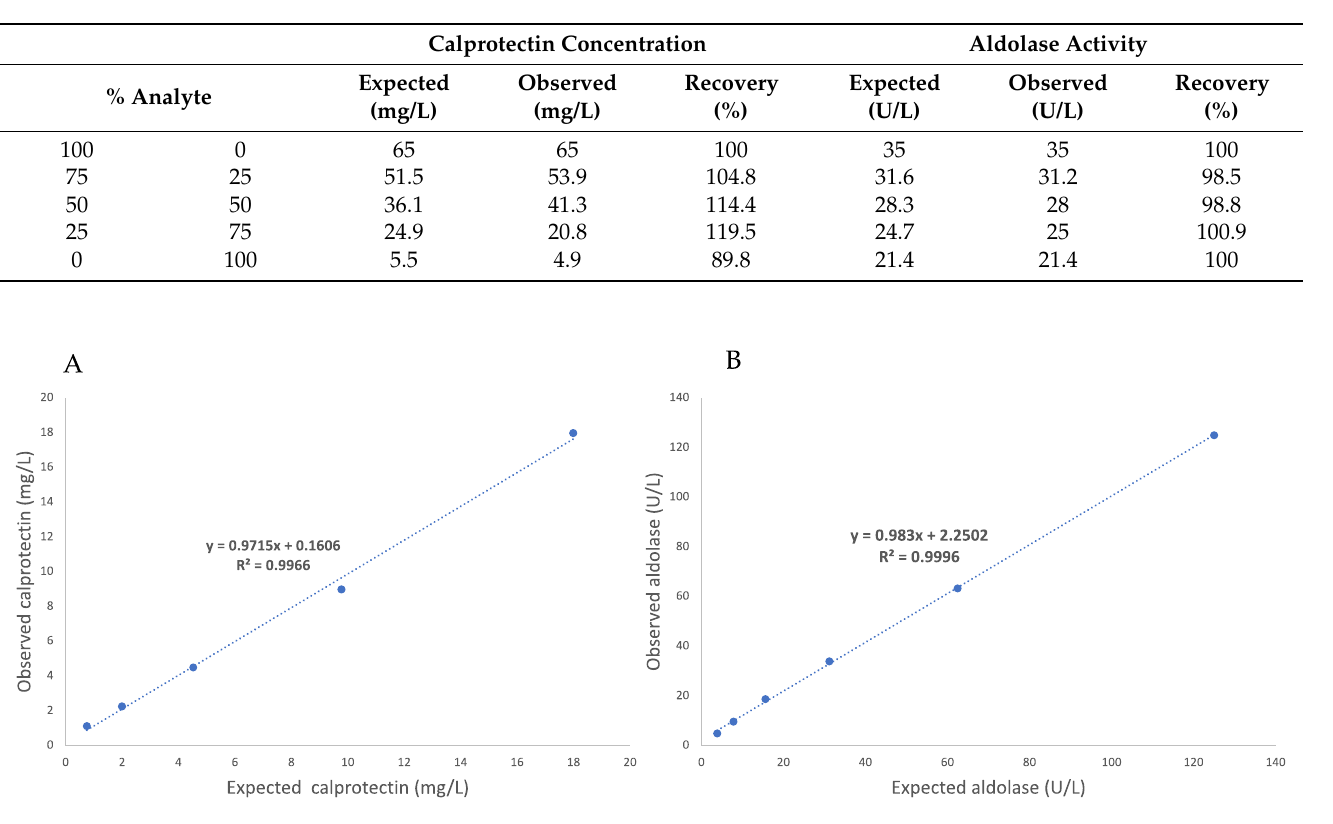
Figure 1. Linearity under dilution study of calprotectin ( A ) and aldolase ( B ) measurements in the saliva of horses.